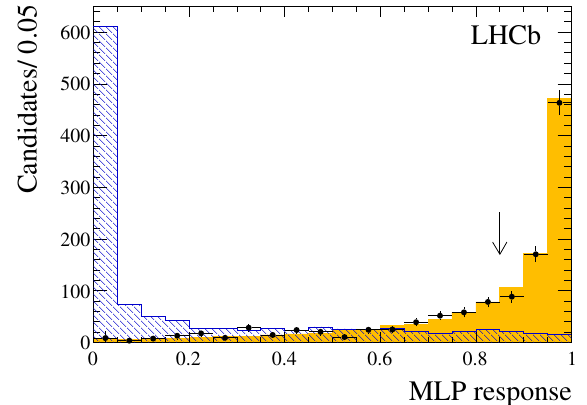
+ K ! (cid:31) (cid:0) simulation sample, (hashed blue) c 1 K s + K ! (cid:31) (cid:0) signal in data. c 1 K s + K ! (cid:31) (cid:0) candidates observed in data c 1 K s